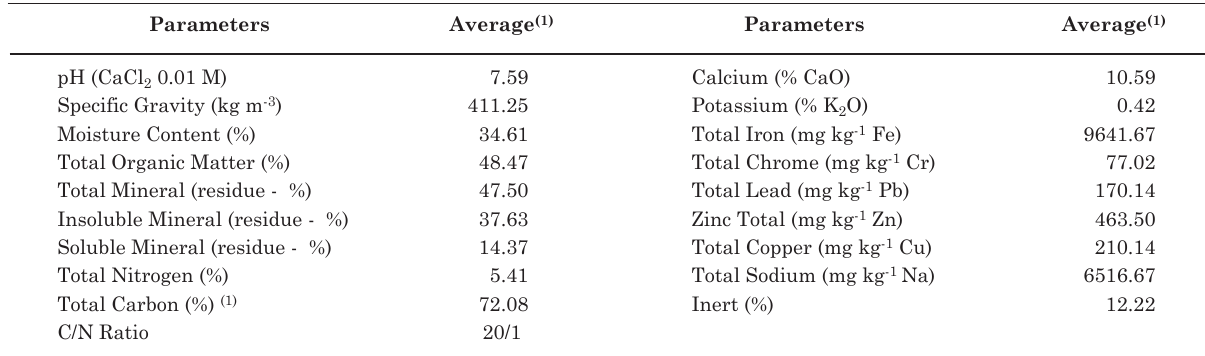
table 3. Chemical analysis of the msW compost from the usina do Caju (% dry